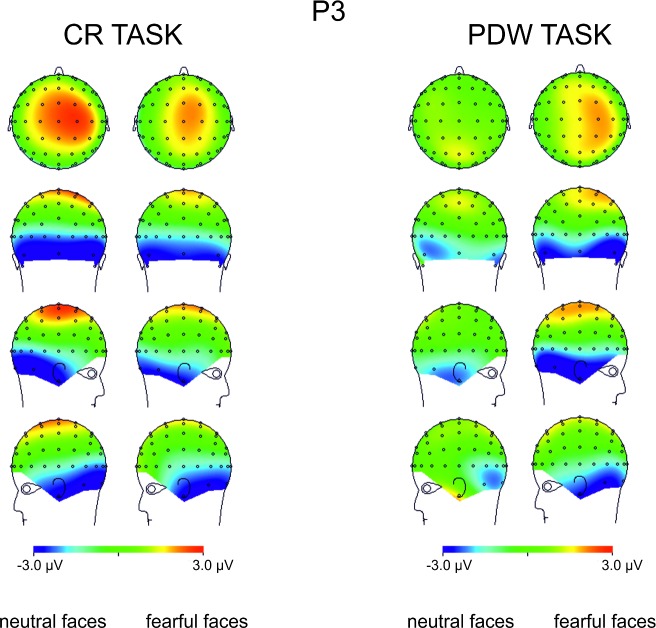
Topographical maps representing voltage differences between brain activity recorded in “aware” and “unaware” trials in the P3 component time interval (300-400ms post-stimulus) illustrated separately for responses to neutral and fearful faces.